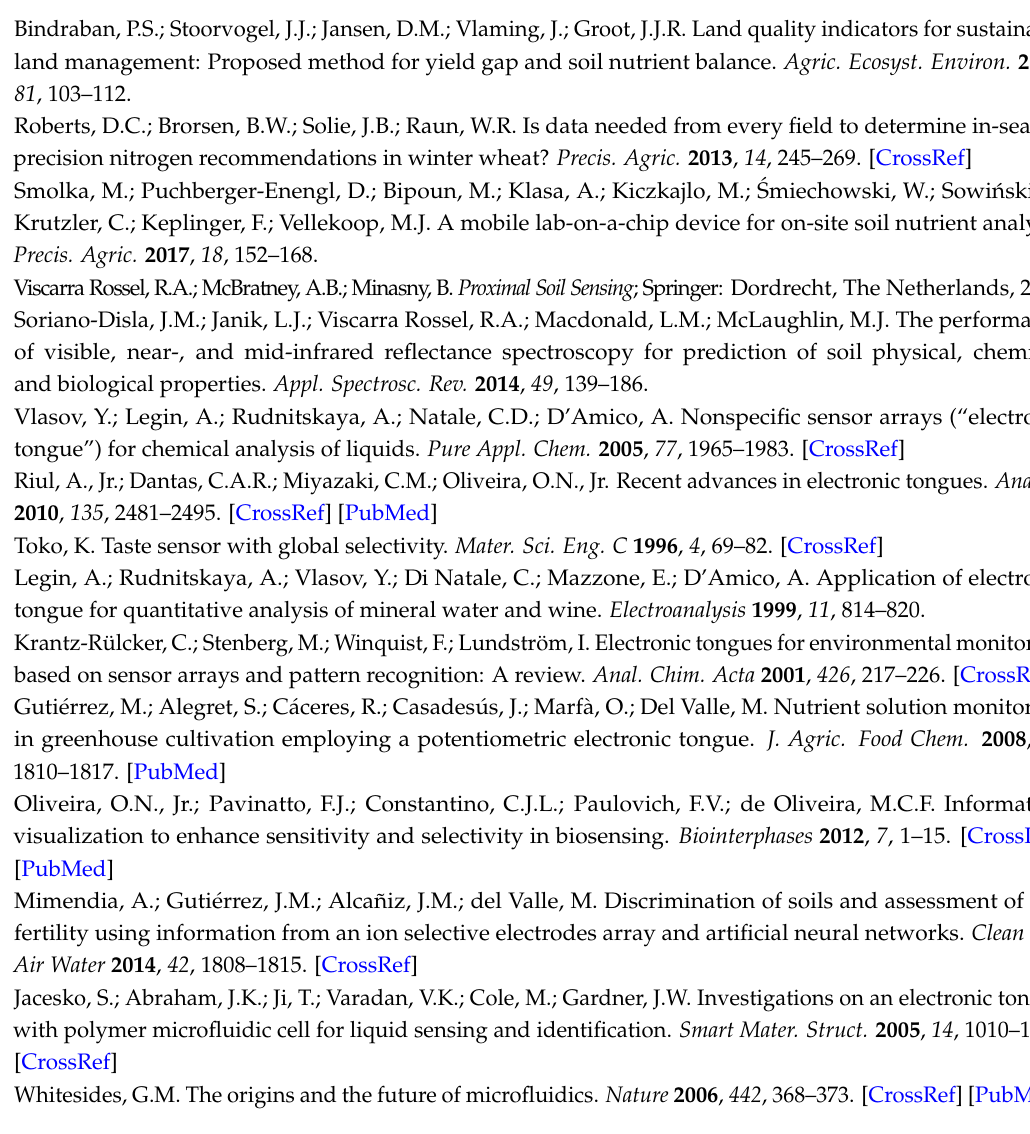
Figure S1: Scheme of the whole setup used for the soil measurement zooming at one sensing unit; Figure S2: Capacitance spectra for the bare electrode, PDDA/CuTsPc, PDDA/MMt-K, and PDDA/PEDOT:PSS sensing units in distilled water at 5000 µ L/h flow; Figure S3: Parallel coordinate visualization of the capacitance data collected with 4 sensing units for the soil samples: (a) all frequencies and (b) with frequency selection, Table S1: The overall characteristics of the original soil collected to be used in the study; Table S2: Nutrients available to the plants according to traditional soil chemical analysis for the seven soil samples